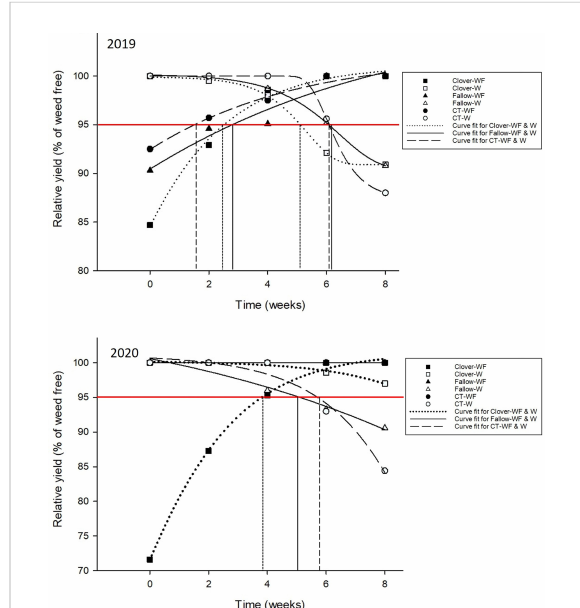
FIGURE 1 The critical period for weed control and its components (critical timing for weed control [CTWR, i.e., weedy] and critical weed- free period [CWFP, i.e., weed free]) for each of the conservation tillage following a crimson clover cover crop (CT + CC), conservation tillage following winter fallow (CT + WF), and conventional tillage without a cover crop (CVT) treatment in 2019 and 2020. Point estimates for CTWR and CWFP for CT + CC, CT + WF, and CVT treatments are presented in Tables 1 – 3. In Figure 1, WF depicted weed-free, and W represented weedy; Fallow referred to winter fallow (CT + WF), clover referred to cover crop (CT + CC), and CT depicted conventional tillage system